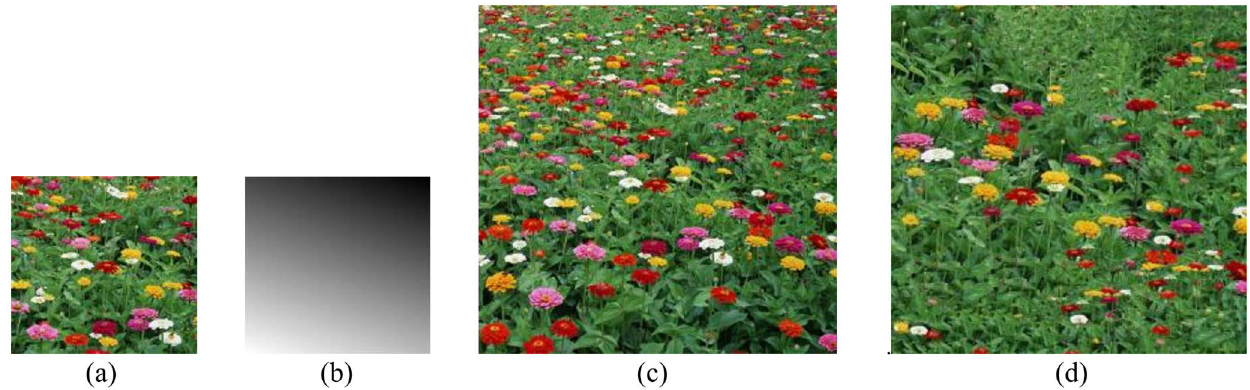
Figure 9. Perspective texture synthesis of a flower image. (a) the input example; (b) scale map with s =60 u , t =20 u ; (c) our result; (d) optimization [Kwatra et al. 2005] result.